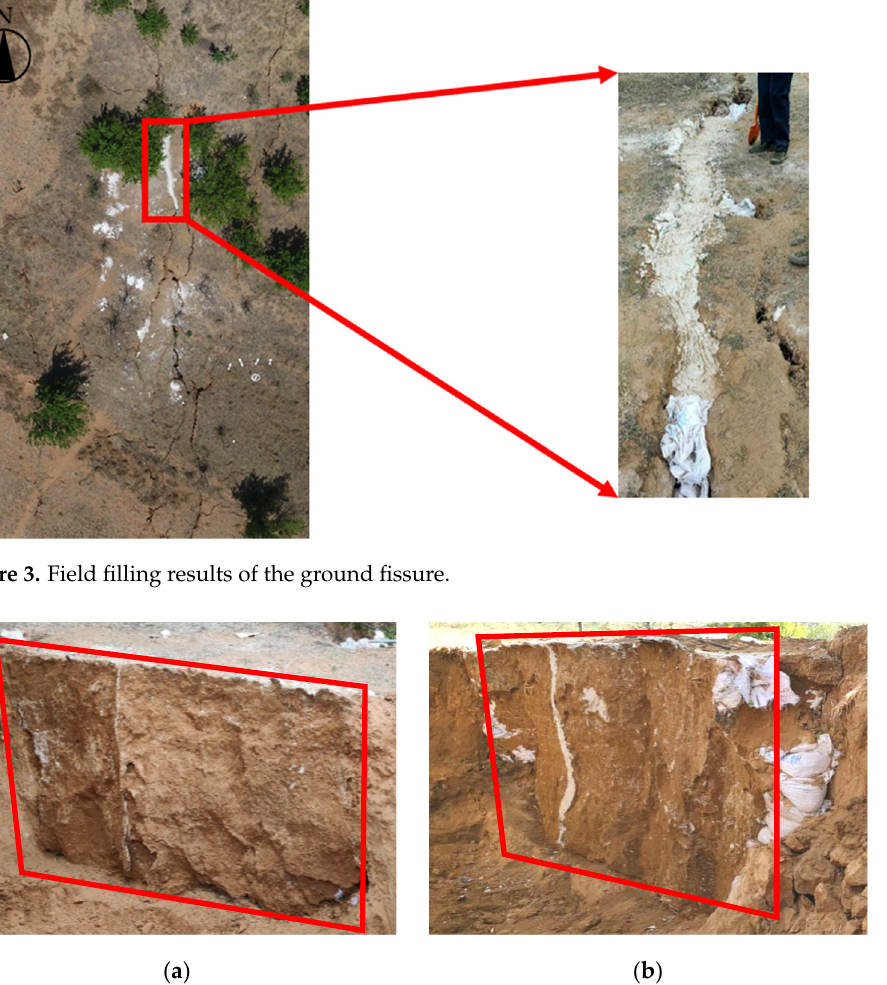
Figure 3. Field filling results of the ground fissure.